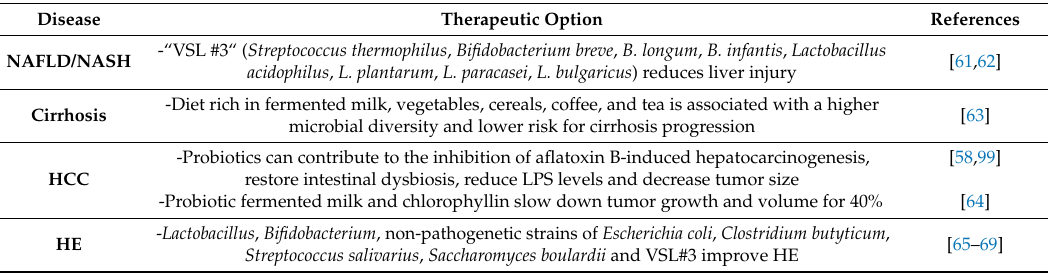
Table 2. Therapeutic options for gut-microbiota alteration in liver diseases. Disease Therapeutic